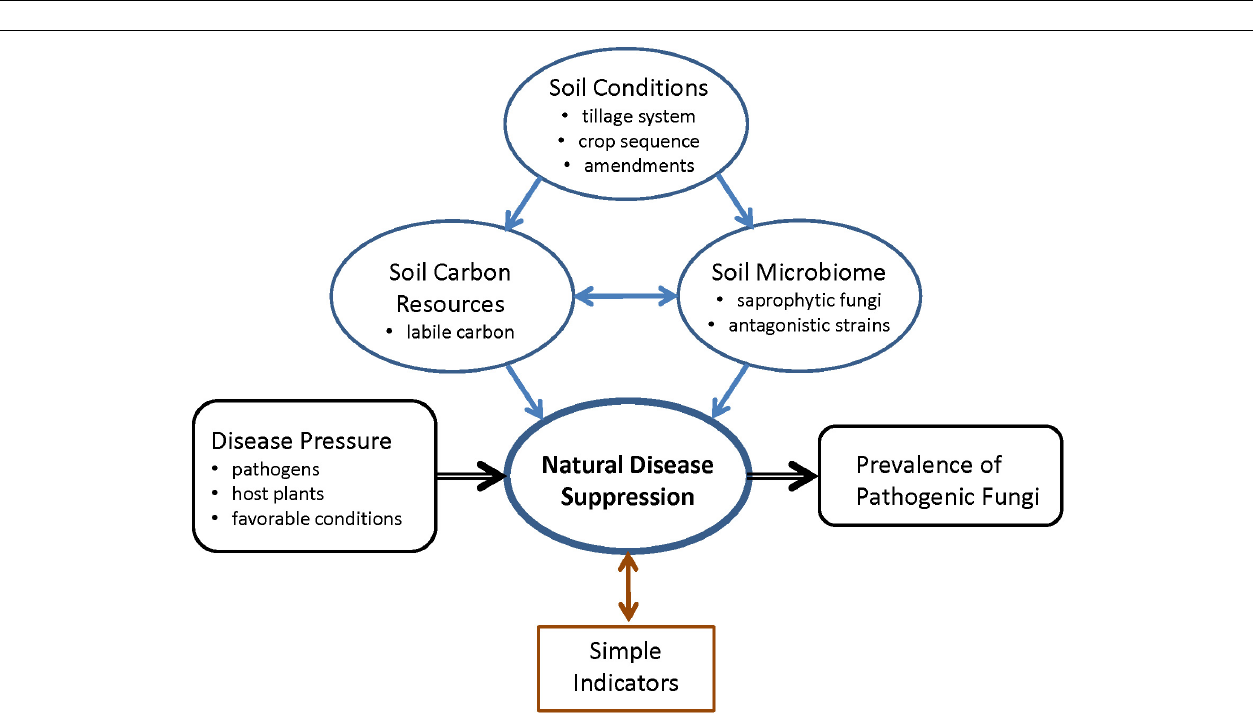
FIGURE 3 | Correlation between fungistasis activity in soil ( y -axis; mm 2 at the surface bioassay; the smaller area – the stronger fungistasis) and (A) prevalence of test fungus F. culmorum ( x -axis; %) on crop stem base; Triangle = monoculture ( r = 0.59, p = 0.04), Square = rotation (oats), r = 0.45, p = 0.15 (all tillage treatments combined), and (B) yield (kg ha − 1 ); Triangle = monoculture ( r = –0.29, p = 0.35; without an outlier ( ∗ r = –0.15, p = 0.03), Square = rotation (oats), r = 0.18, p = 0.58 (all tillage treatments combined).